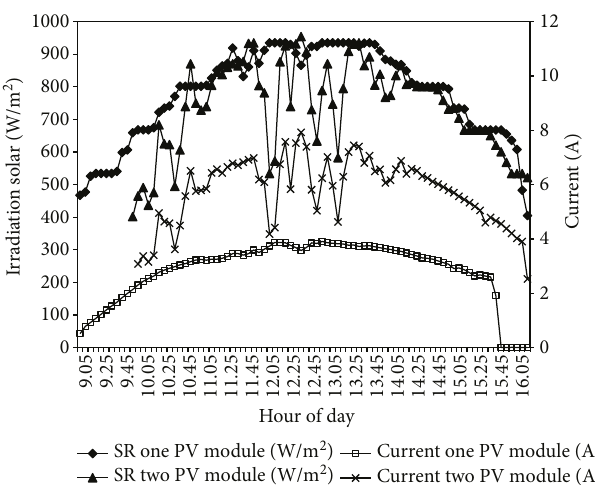
Figure 6: Solar irradiation pro fi les as function of time: SR one PV module, SR two PV module, current one PV module, and current two PV module.